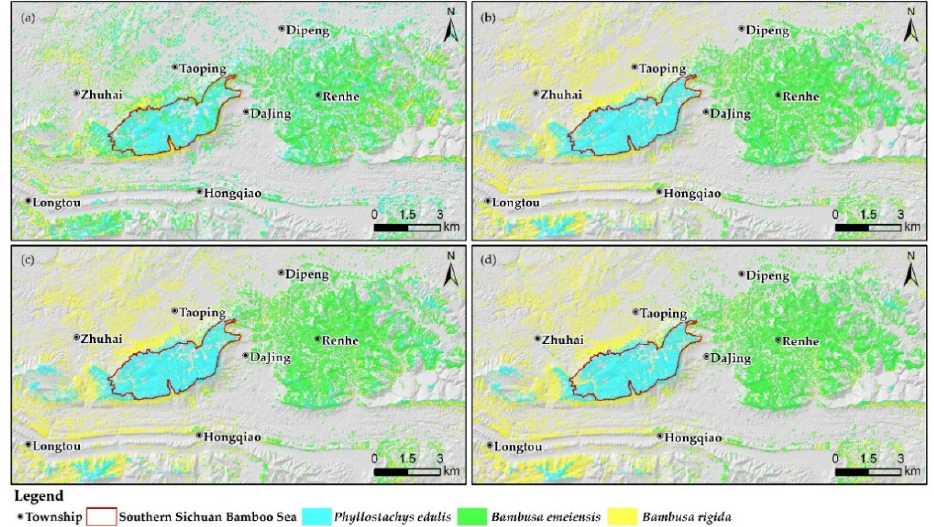
Figure 10. Classification maps: ( a ) SAM, ( b ) XGBoost (all variables), ( c ) XGBoost (important varia- bles), and ( d ) XGBoost (important and uncorrelated variables).